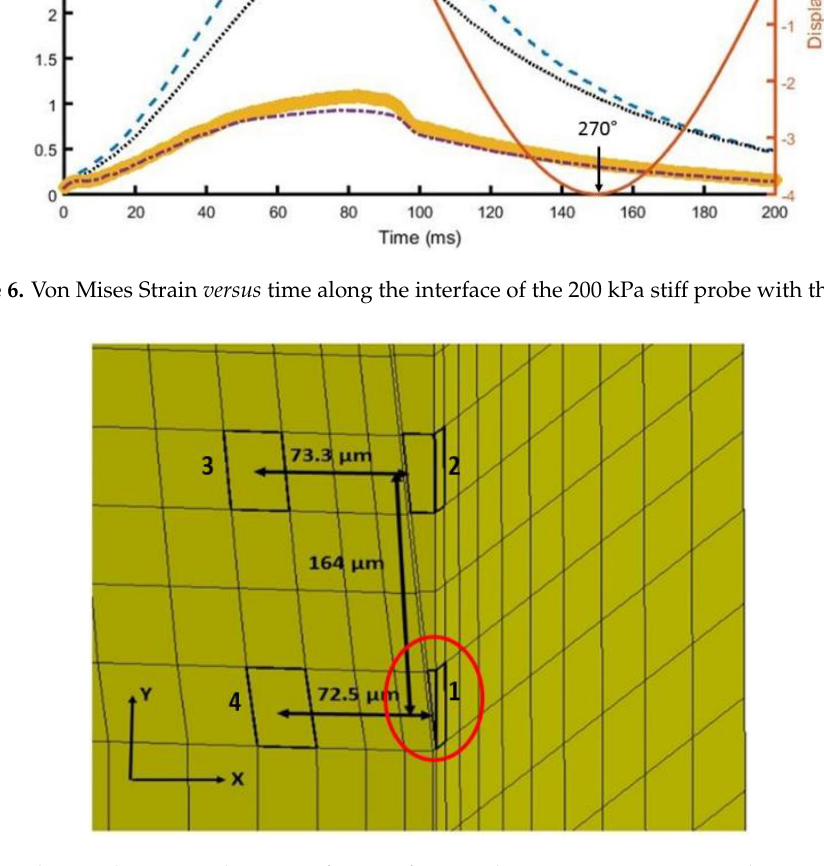
Figure 7. Element locations along interface tip for time history traces corresponding to graphs in Figures 5 and 6.